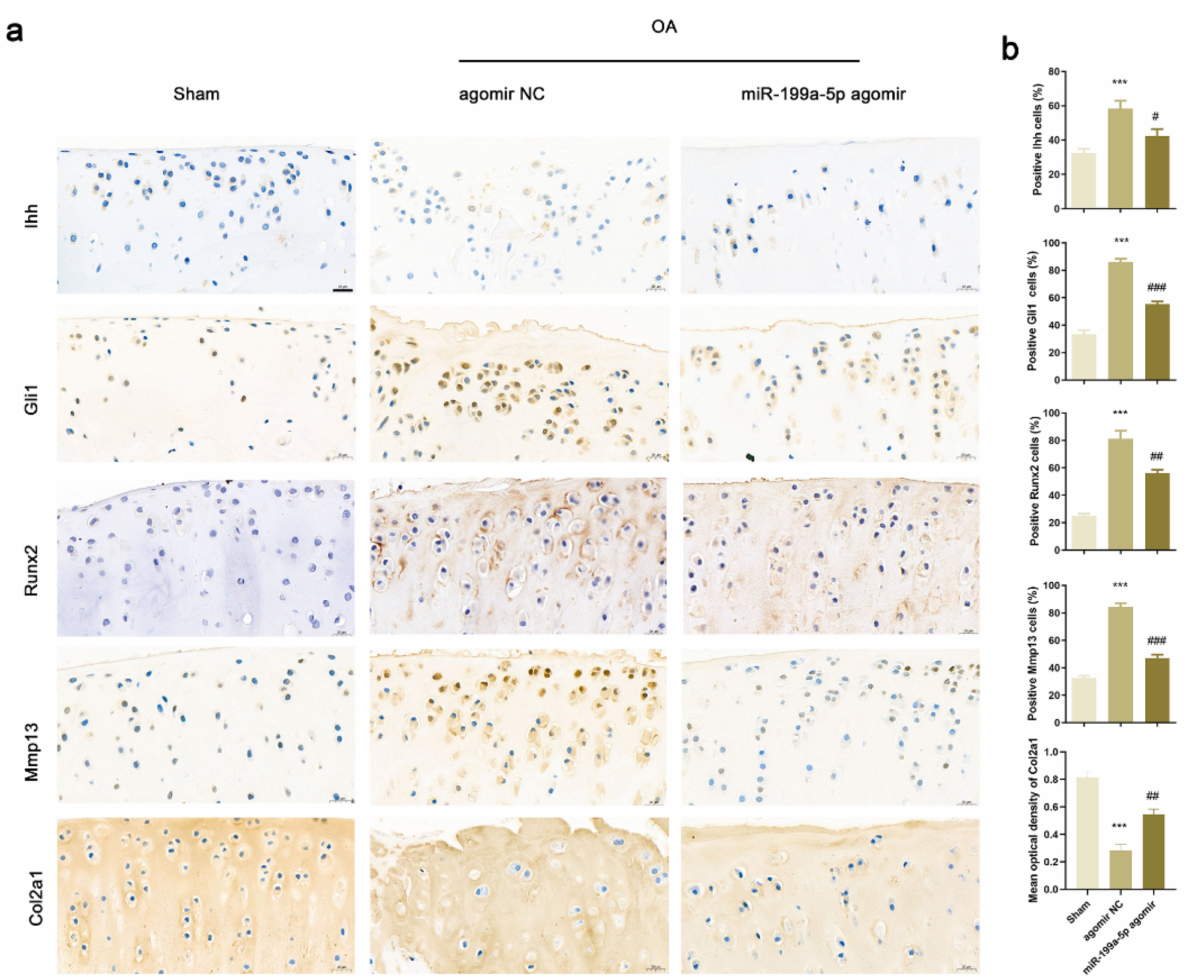
Figure 6. miR-199a-5p regulated molecular markers associated with chondrocyte hypertrophy and matrix degradation via Ihh signaling pathway in rats. ( a ) Immunohistochemical staining of Ihh, Gli1, Runx2, Mmp13, and Col2a1. ( b ) Statistical analysis of the chondrocytes positive for Ihh, Gli1, Runx2, Mmp13, and Col2a1. Scale bar represents 20 µ m. (*** p < 0.001 versus sham group; # p < 0.05, ## p < 0.01, ### p < 0.001 versus agomir NC group; n = 6 for each